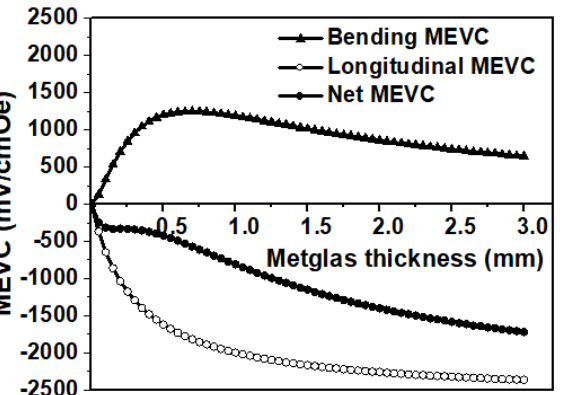
Figure 6. Results on estimated MEVC vs. t m , as in Figure 2 for a bilayer of Metglas and PZT for t p = 0.5 mm.